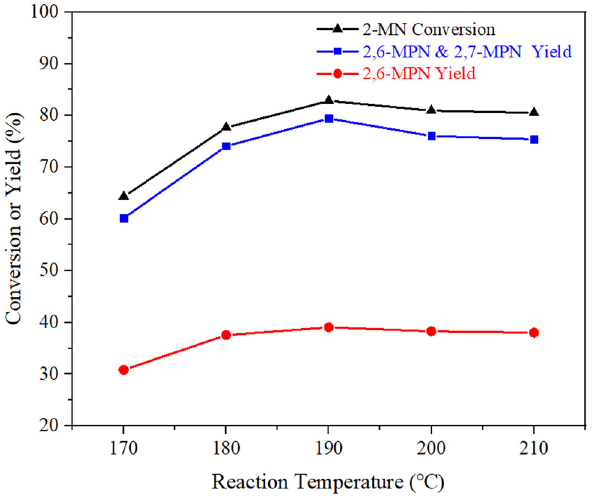
Figure 12: E ff ect of reaction time on propionylation of 2 - MN. Reaction conditions: n ( 2 - MN ) : n ( PA ) = 1:1.8, TS 10 g, AlCl 3 /H β ( AlCl 3 3 g · L − 1 , re fl ux for 9 h and calcination at 550°C for 3 h ) 3 g, 190°C, 10 h.